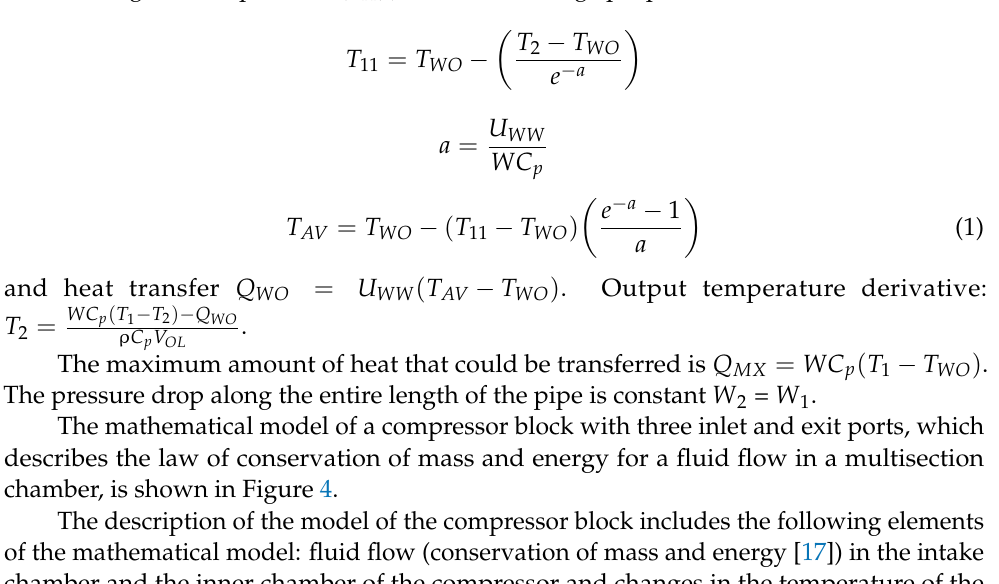
Figure 3. The functional view of the block of the water section of the heat exchanger. To calculate the heat transfer in the block of the heat exchanger’s water section, the amount of incoming heat T WO is taken into account: this is the temperature of the exchanger core. Average air temperature ( T AV ) for heat exchange purposes